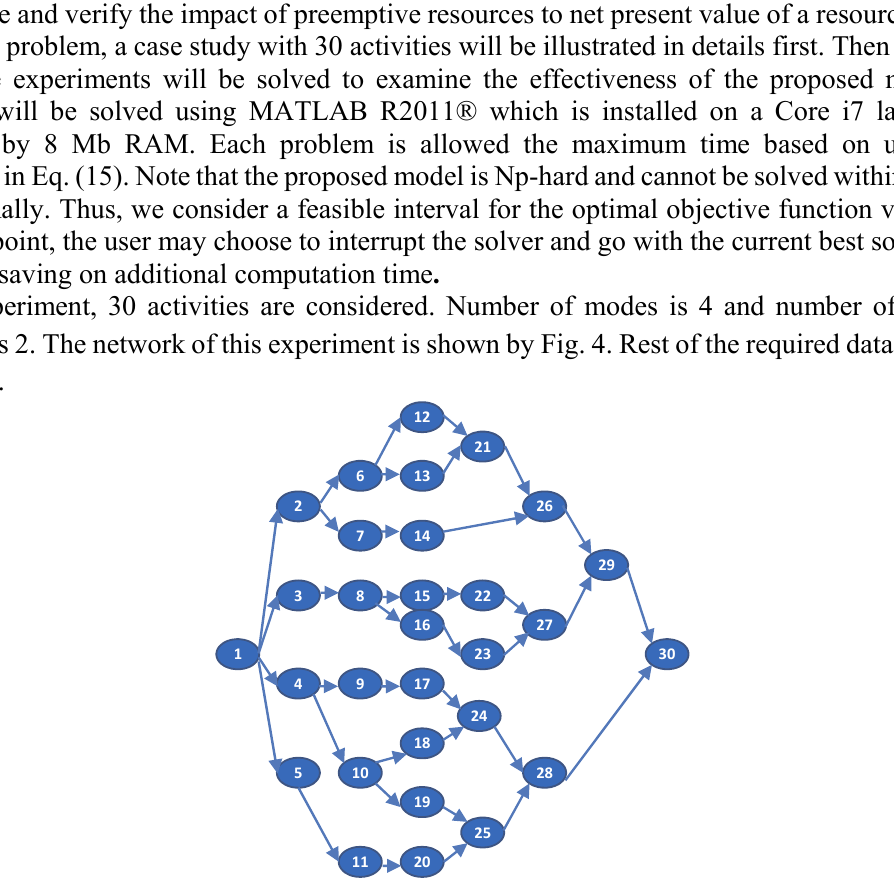
Fig. 4. Network diagram for the